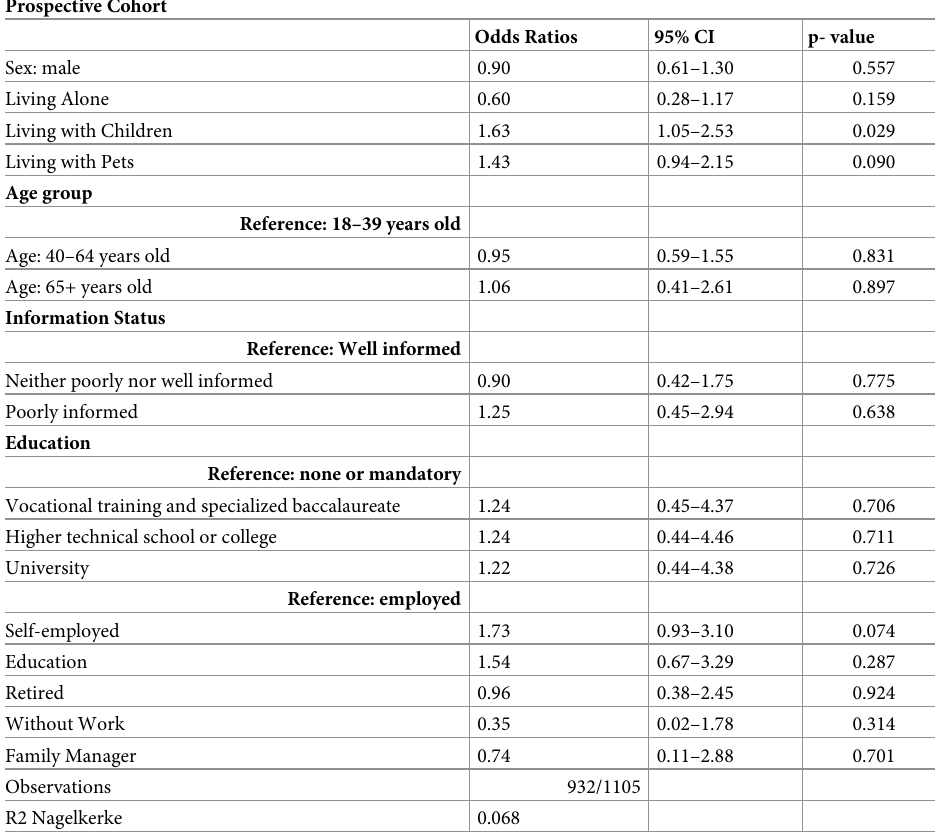
Table 3. Influence of sociodemographic background on complying to Isolation recommendations in multivari- able ordinal regression. Prospective Cohort